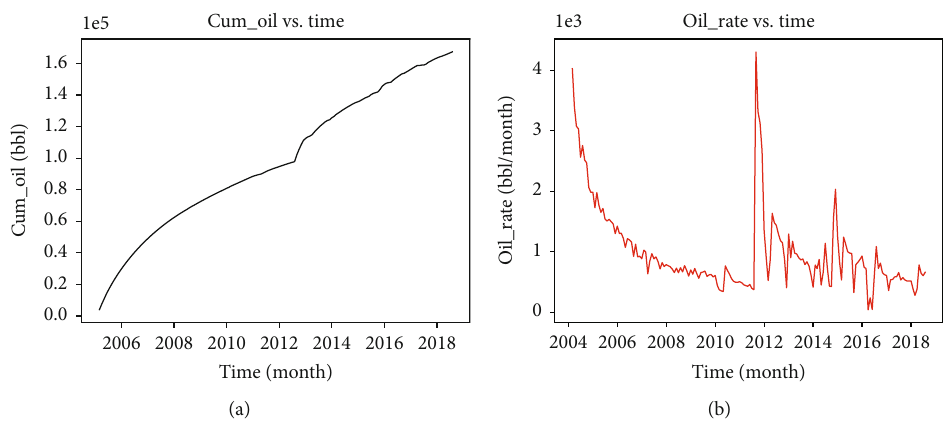
Figure 13: Cumulative oil production and rate as the function of time in Bakken formation with EOR.